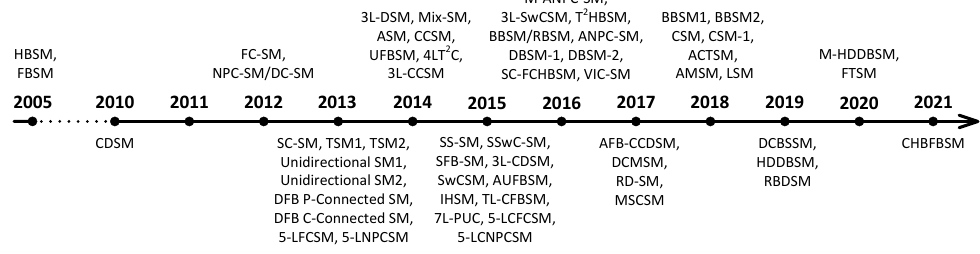
Figure 13. Timeline of SM introduction in the literature.